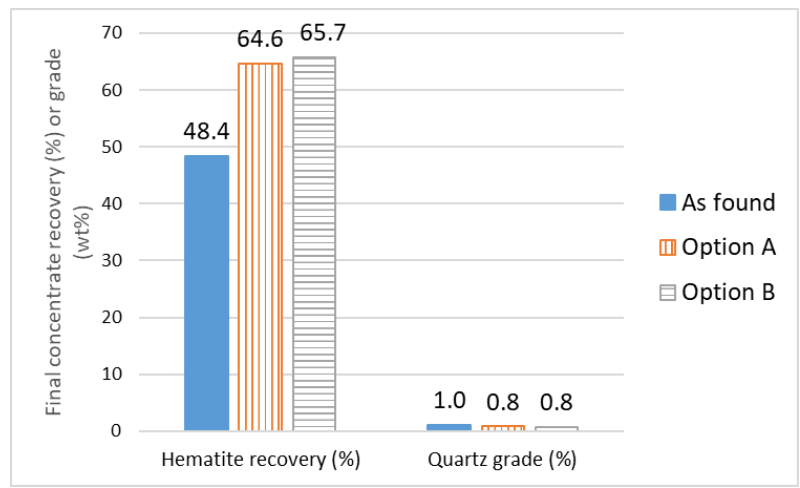
Figure 8. Final concentrate hematite recovery, based on plant feed, and quartz grade for “as found” and option A and B of scenario 2.